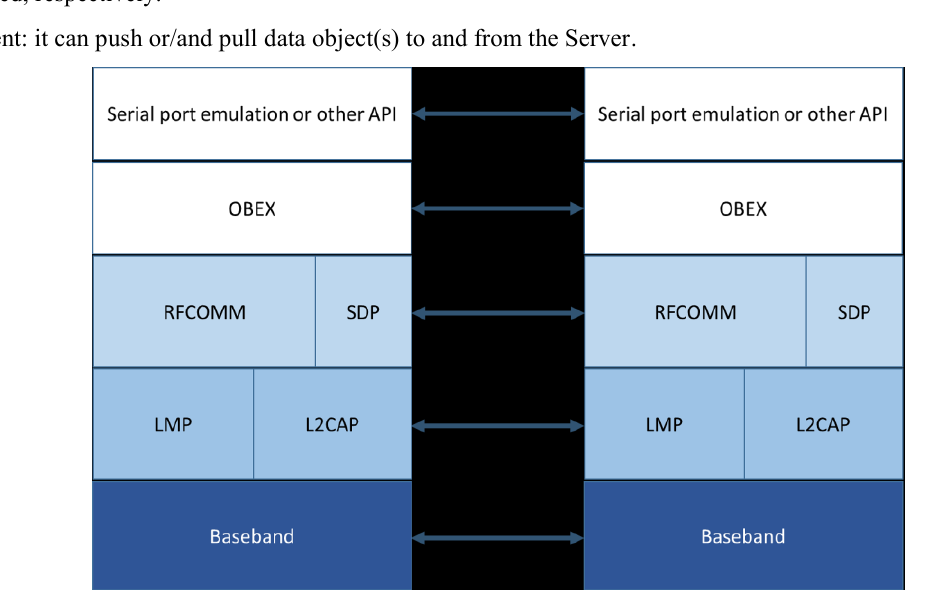
Figure 4. Bluetooth GOEP Profile and the interacting